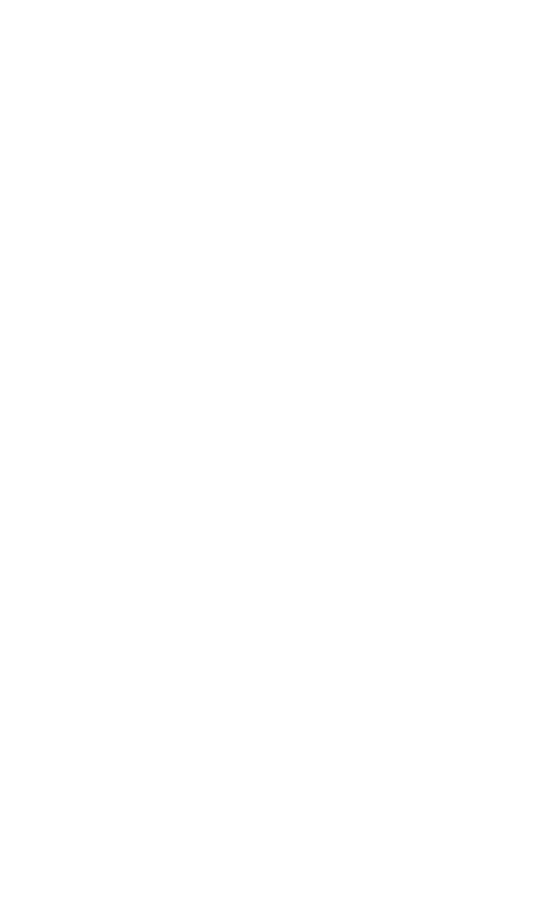
Figure 1. Diagram representing the structure of the DAB2 protein and location of important functional domains.